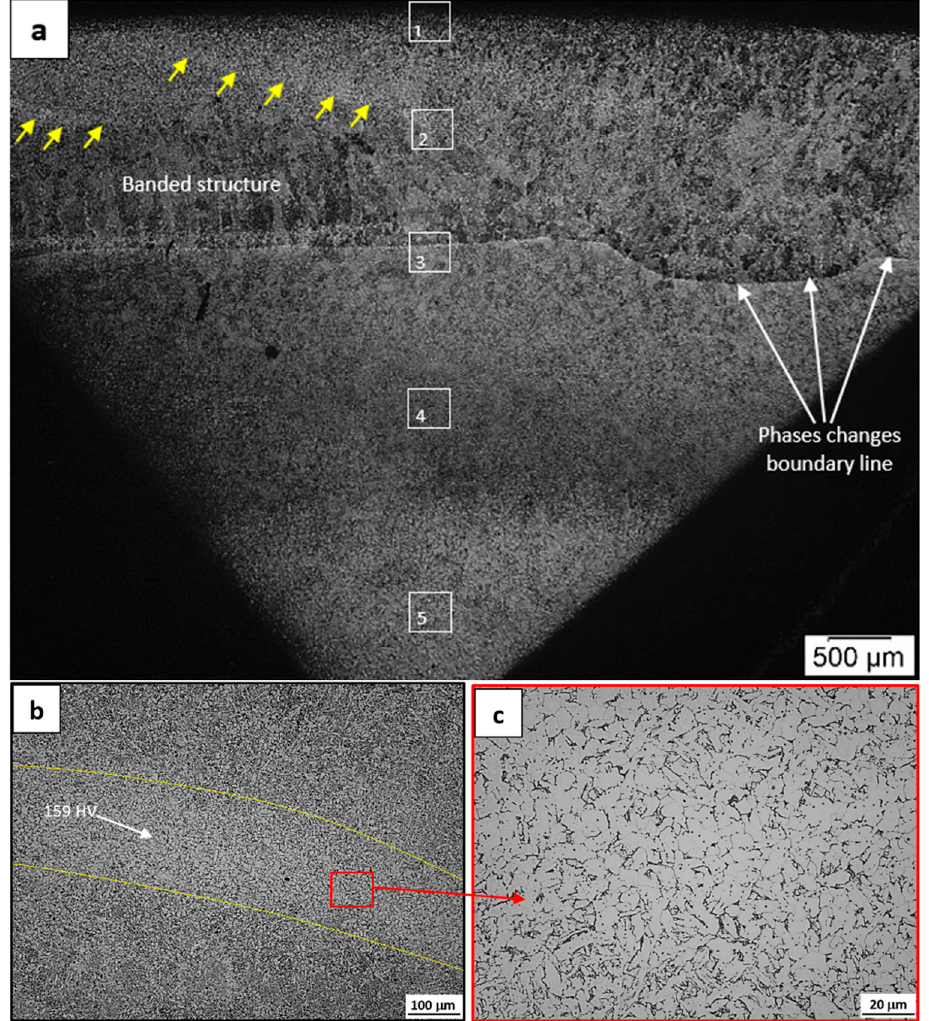
Figure 7. ( a ) Optical micrograph of the transversal section showing the microstructural change from the surface to the shaft core. Yellow arrows indicate the localization tracks of polygonal ferrite nucleated with a small amount of perlite; ( b ) detail of ( a ); ( c ) polygonal ferrite and pearlite nucleated in the area of the banded structure.